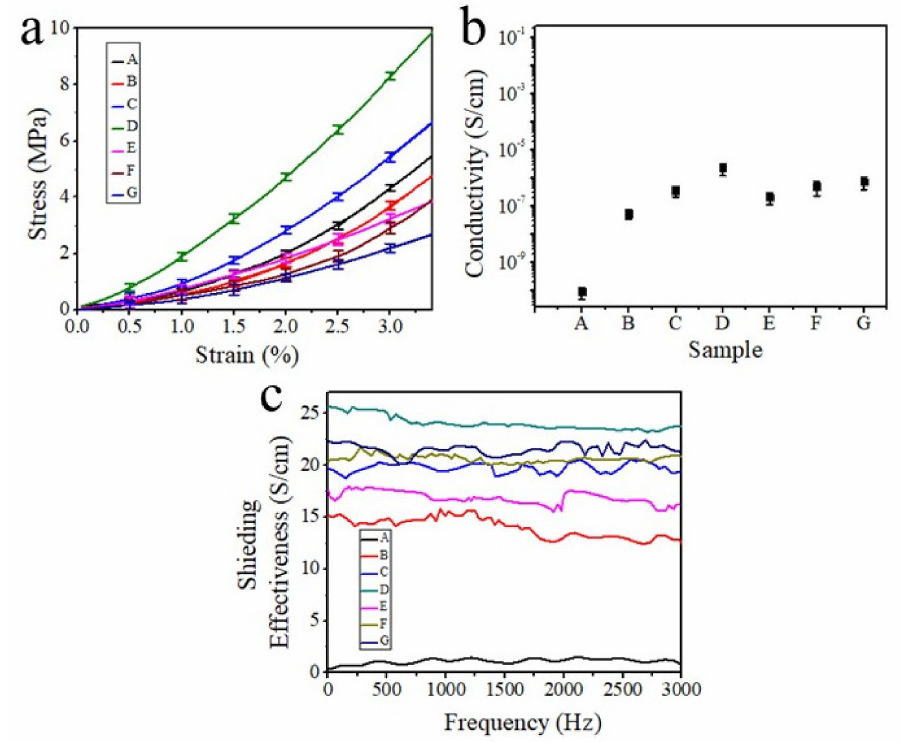
Figure 6. ( a ) Mechanical properties, ( b ) electrical conductivity, and ( c ) electromagnetic shielding performance of the PVP / γ -Fe 2 O 3 nanofiber membrane fabricated by MES; A: PVP fibers